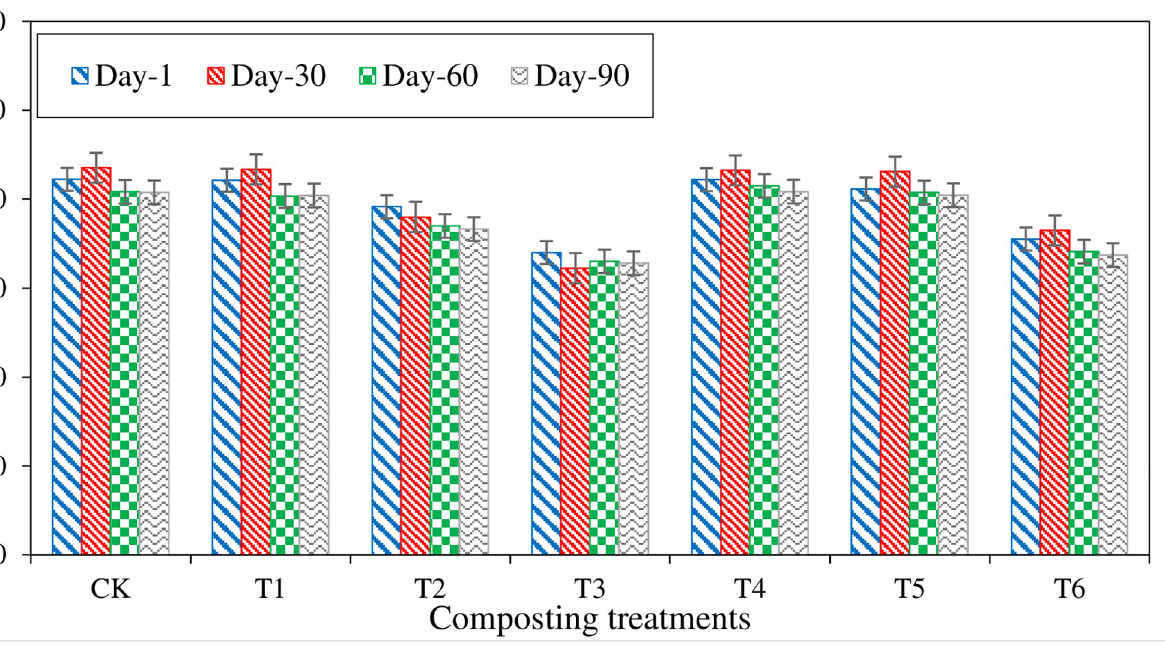
Fig 2. pH values measured from different composting